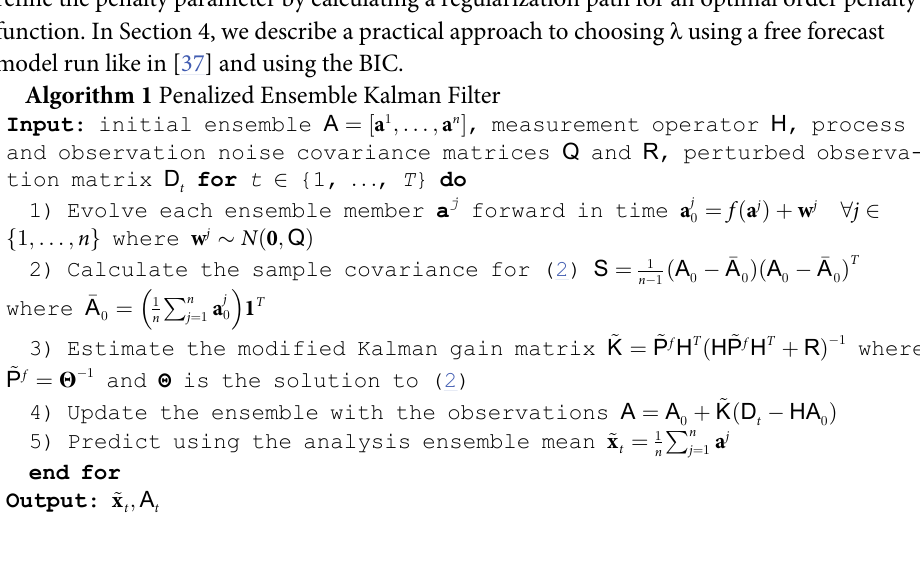
Algorithm 1 Penalized Ensemble Kalman